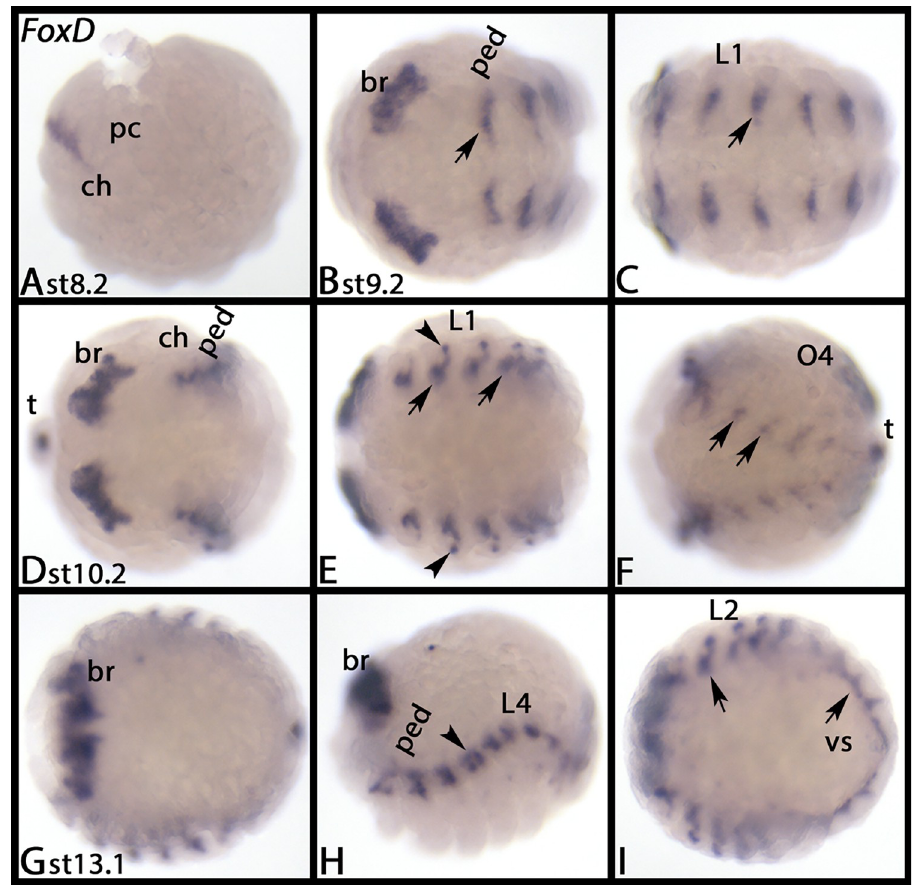
Fig 6. Expression of Parasteatoda FoxD . In all panels, anterior is to the left, ventral views, except panels G, dorsal view and A, H, lateral view. Each row represents the same embryo, except for first row. Arrows point to expression in the VNS. Arrowheads point to expression at the base of the limbs. Abbreviations in Table 2. DAPI staining of the embryos shown in this figure are presented in S10 Fig.